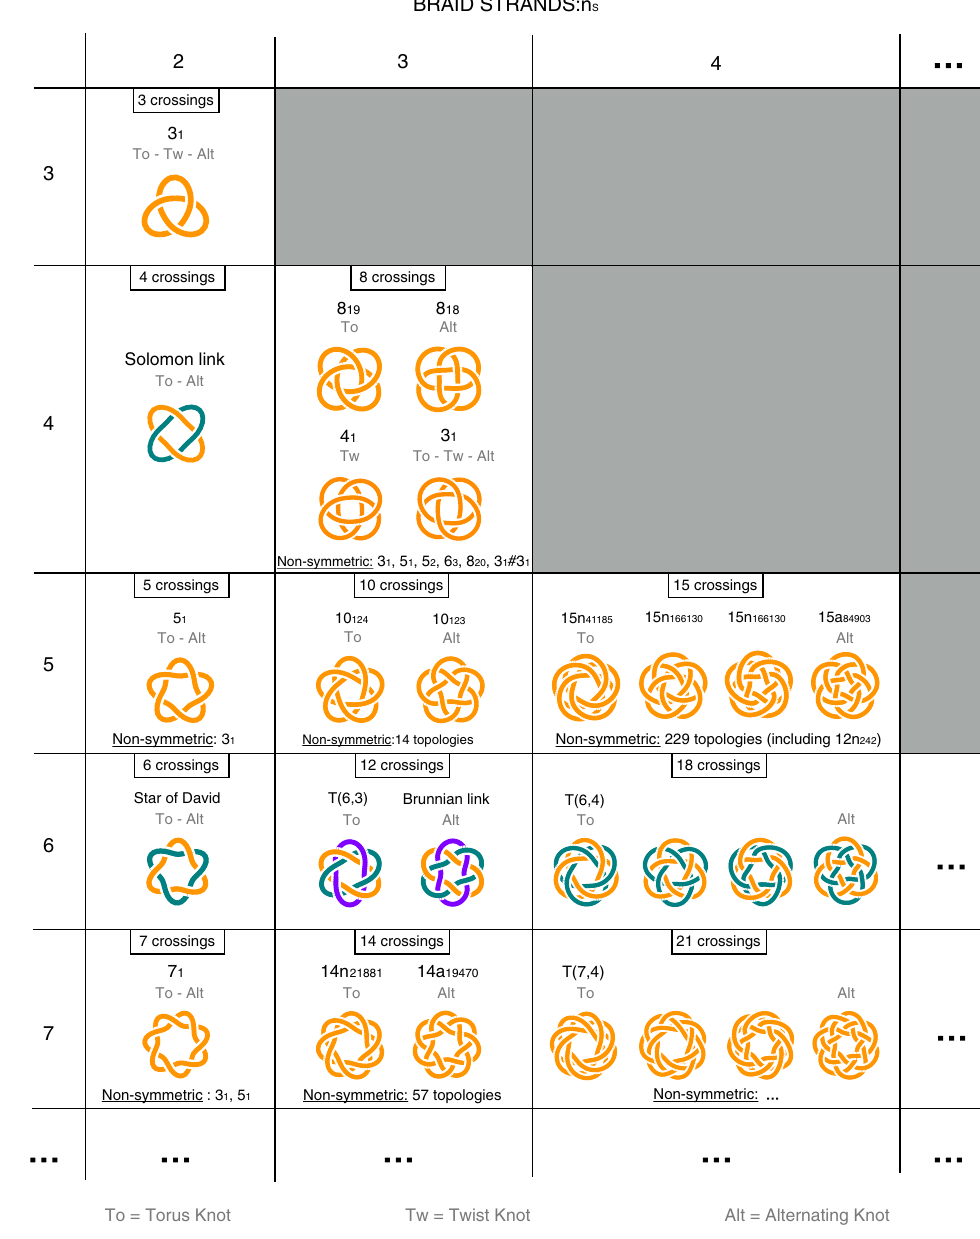
Fig. 4 Graphical table of non-trivial topologies with planar cyclic-symmetric representations. Non-trivial knots and links with cyclic-symmetric planar representations are organised in terms of n T and n S . The former is the number of constitutive templates, i.e. modular units with projections covering less than a full turn, which is taken equal to the number of crests on each edge of the corresponding linear braid; the latter is the number of strands in the braid itself. The number of projected crossings (an upper bound to the crossing number) is n T × ( n S − 1) and is identical for various topologies obtainable with the same combination ( n T , n S ). For knots all inequivalent symmetric diagrams are shown, while for links only those with the highest degree of cyclic symmetry are presented for n T = 6. Various non-symmetric instances are listed too. The complete list of knots is given in Supplementary Figs. 8 –